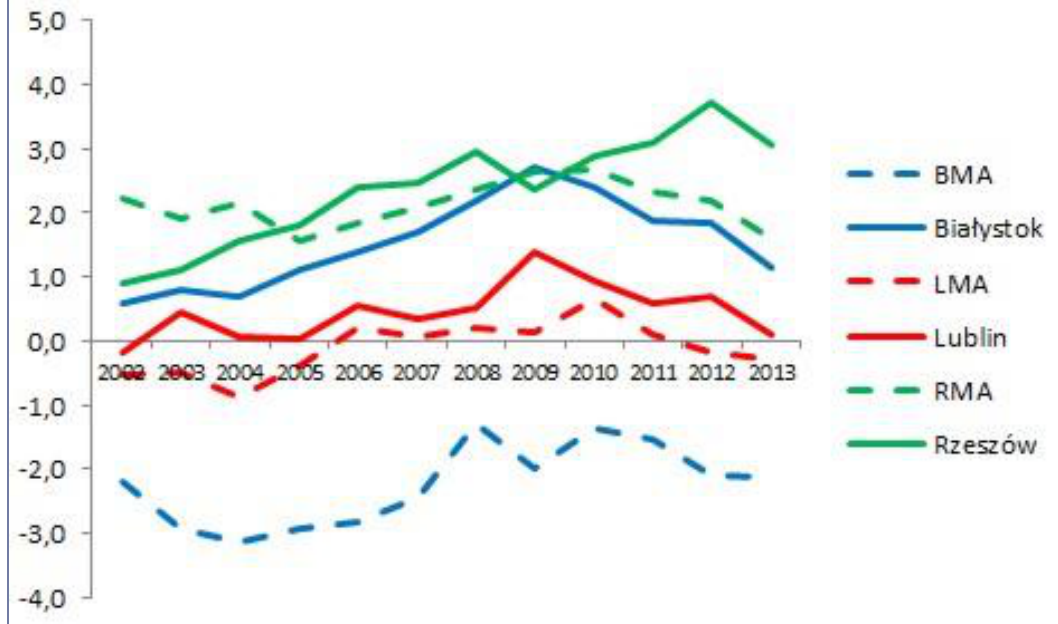
Fig. 3. Dynamics of natural population growth in the Białystok, Lublin and Rzeszów Metropolitan Areas (2002-2013) (author’s own elaboration based on data from the Local Data Bank of the Central Statistical Office)